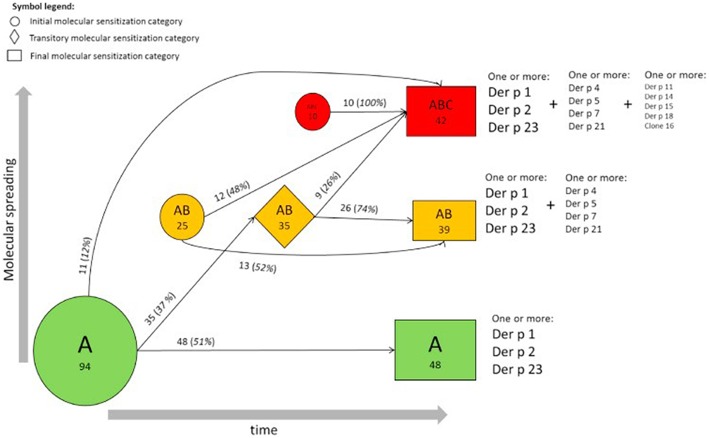
Trajectories of IgE sensitization in mite-sensitized subjects (n = 129). Evolution of the IgE responses to 12 D pteronyssinus allergen molecules according to the A, AB, or ABC classification in participants sensitized at 2 or more follow-up points is shown. The round, rhombus, and rectangular boxes represent the initial, intermediate, and final sensitization stages, respectively. Numbers (percentages) refer to participants, and areas are proportional to their frequency [reprinted from (14), Copyright 2017, with permission from Elsevier].